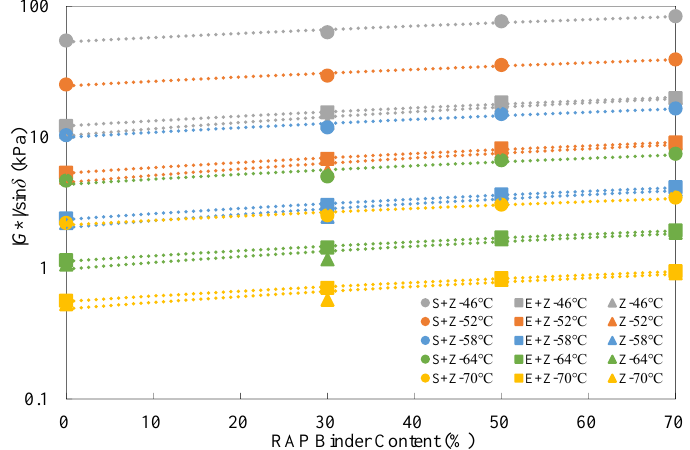
Figure 6. Rutting parameter test results of the warm-mix recycled binders at different RAP binder contents under the unaged condition. Table 5. Percentage increase in | G *|/sin δ with the RAP binder content under the unaged condition.